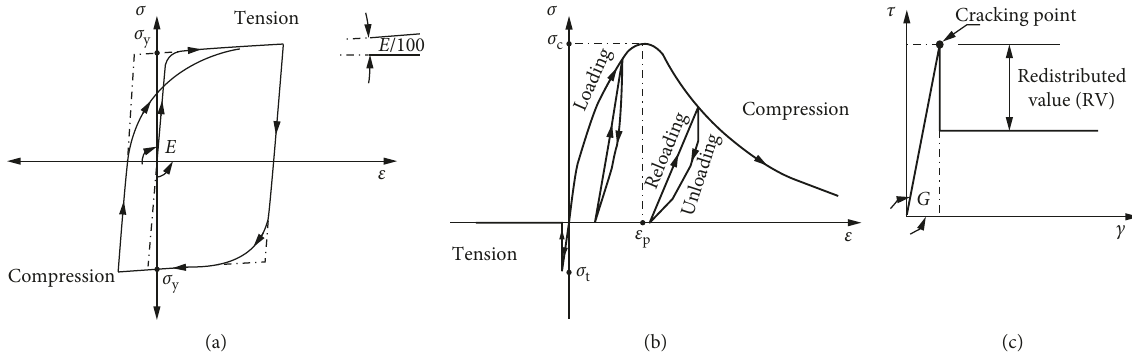
Figure 2: Constitutional curves used in AEM for concrete and reinforcements. (a) Concrete under axial stresses, (b) concrete under shear stresses, and (c) reinforcement under axial stresses [18].